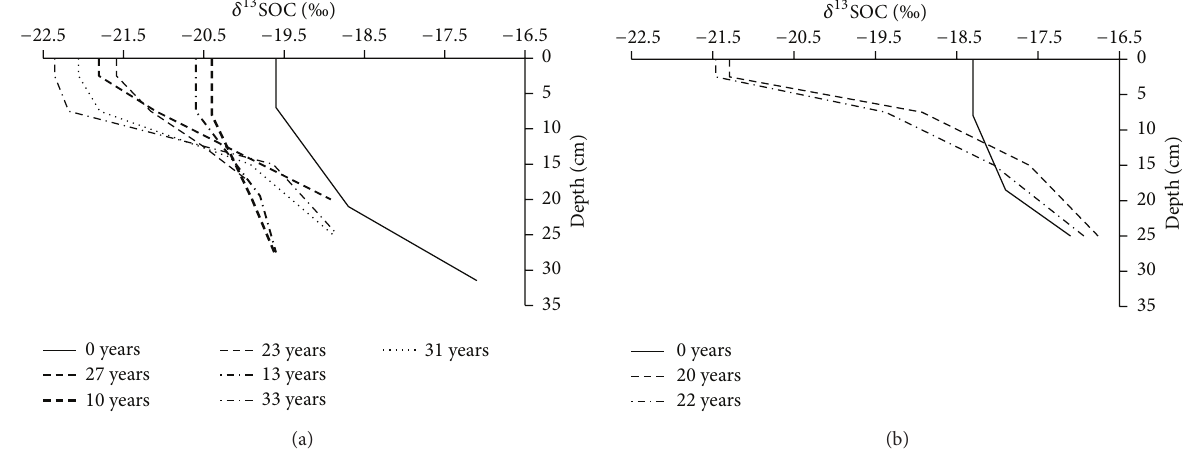
Figure 3: Distribution of mean 13COS values with depth and their evolution in sites A (a) and B (b).